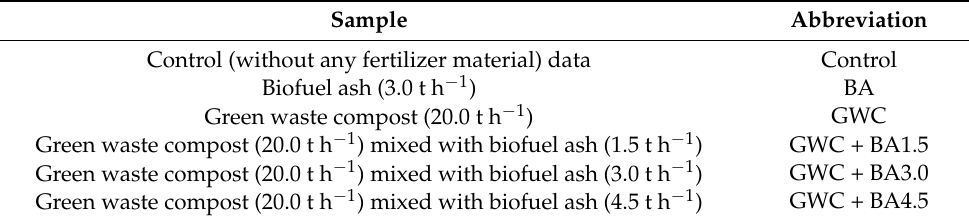
Table 1. Green waste compost and biofuel ash samples used in the experiments. Sample